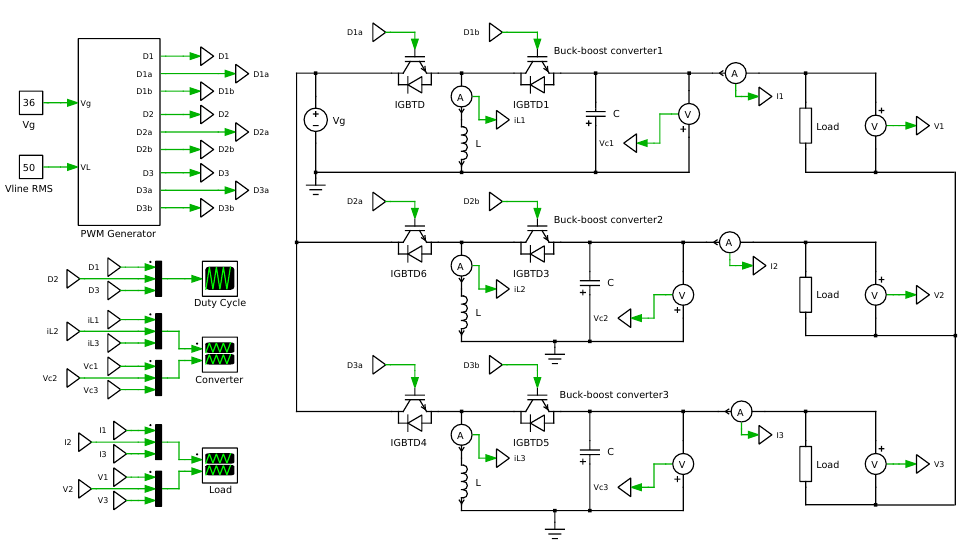
Figure 9. Three-phase inverter PLECS schematic.